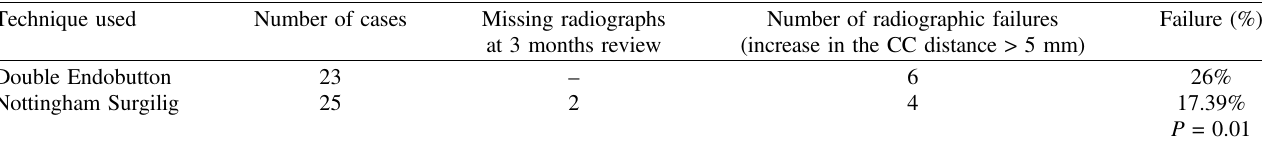
Table 2. Radiographic failure by surgical technique.